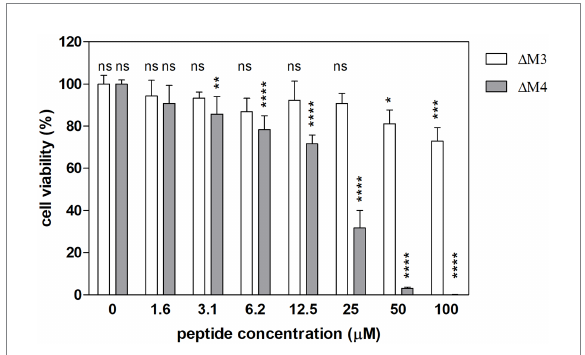
FIGURE 9 Viability of human dermal fibroblasts (HDF) after treatment with Δ M3 and Δ M4 peptides. The cytotoxicity of the peptides was assessed with Alamar blue test in primary HDF. Cells, seeded on microplate (1 × 10 5 ), were treated with peptides at different concentrations for 24 h in culture HDF basal medium. After medium removal, 100 μ l of Alamar blue reagent were added. Fluorescence was measured at λ ex = 560 nm, λ em = 590 nm with Synergy H1 microplate reader after 1 h of incubation. The cell viability is presented as the percentage of the untreated cells, the number of which was assumed as 100%. The samples were performed in triplicate. The bars present the mean ± SD ( n = 3). Statistical analysis was performed with two-way ANOVA with Tukey’s multiple comparison test. Selected statistical significances were presented vs. untreated cells. * p < 0.05, ** p < 0.01, *** p < 0.005, **** p <